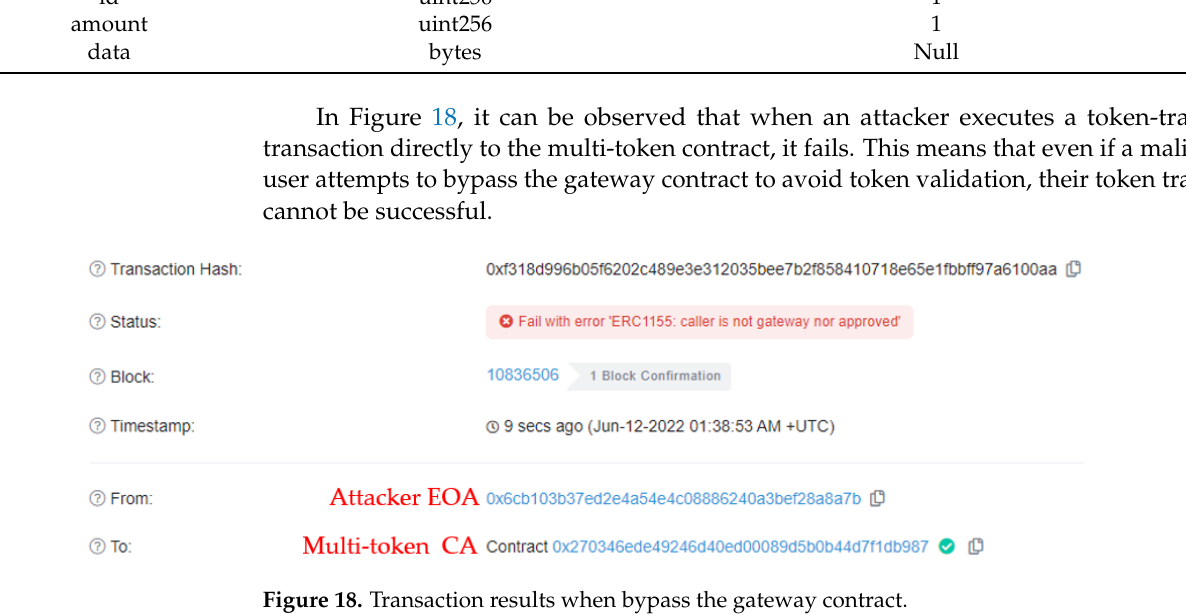
Figure 17. Transaction results when sending tokens exceeding the threshold.